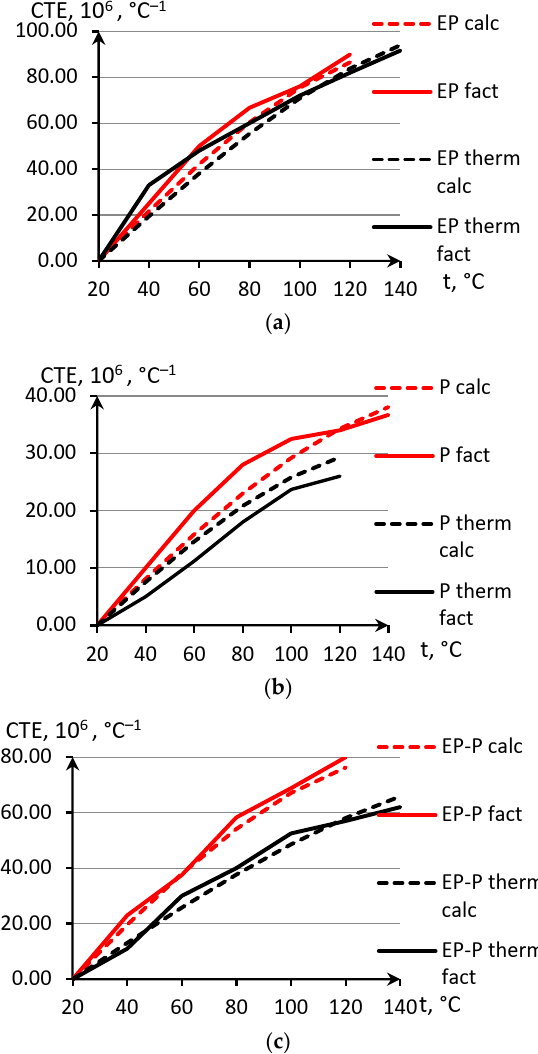
Figure 10. Experimental and model curves of GPs’ CNTE until T g .( a ) EP, ( b ) PF, ( c ) EP-PF